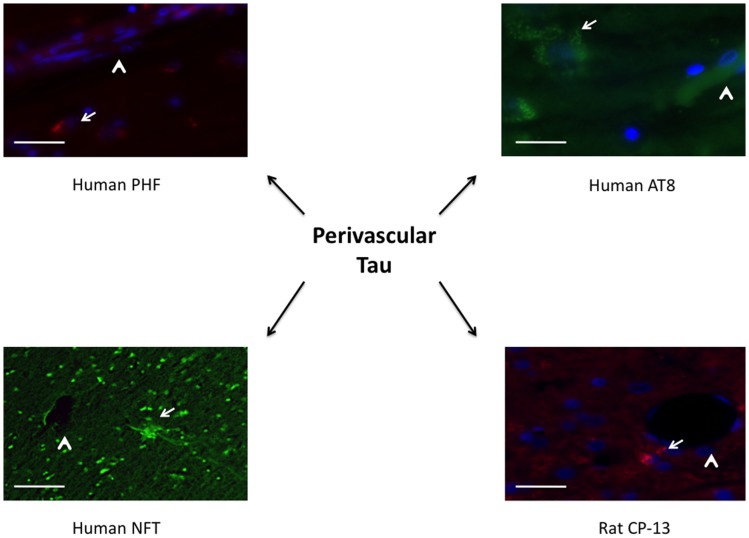
Tauopathy is seen in a perivascular distribution. PHF and AT8 were increased adjacent to longitudinal microvessels in human patients diagnosed with chronic traumatic encephalopathy. A neurofibrillary tangle stained with thioflavin was seen adjacent to a cut vessel lumen in the brain of a retired professional football player. Similarly, CP-13 was increased next to a cut vessel lumen in the contralateral cortex 1 month following repeat blast in the rat. Arrows indicate tauopathy while arrow heads point out vessels.